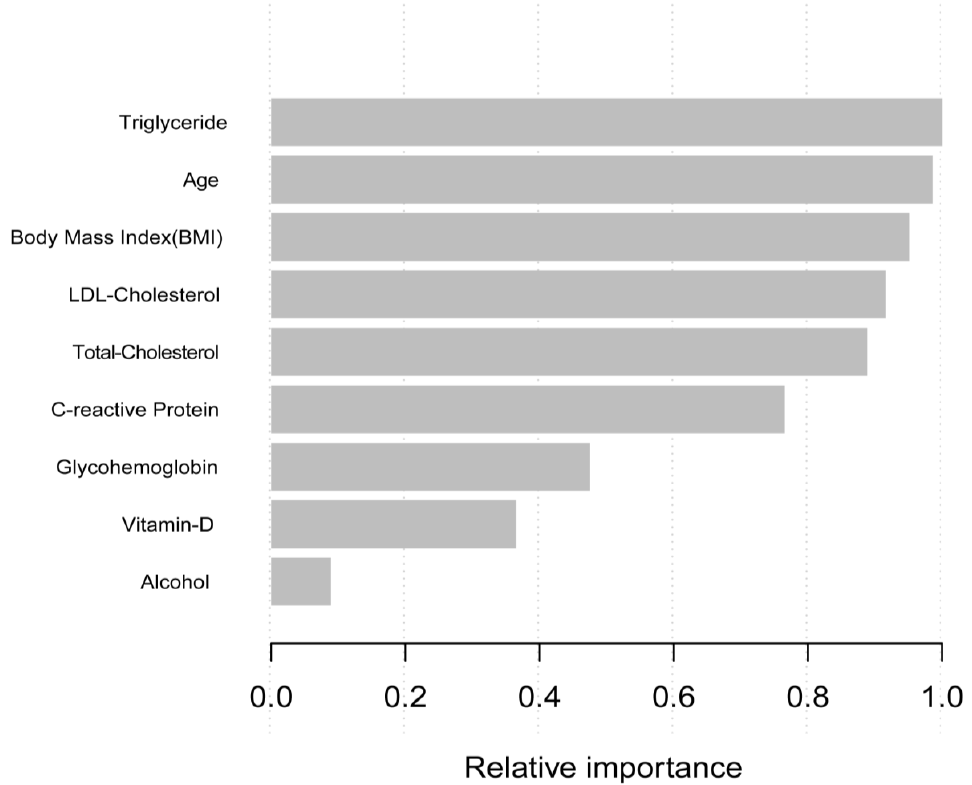
Figure 2. Relative importance of the selected variables using XGBoost and the corresponding vari- able importance score. X -axis indicates the importance score, which is the relative number of a variable that is used to distribute the data, Y -axis indicates the selected variable.